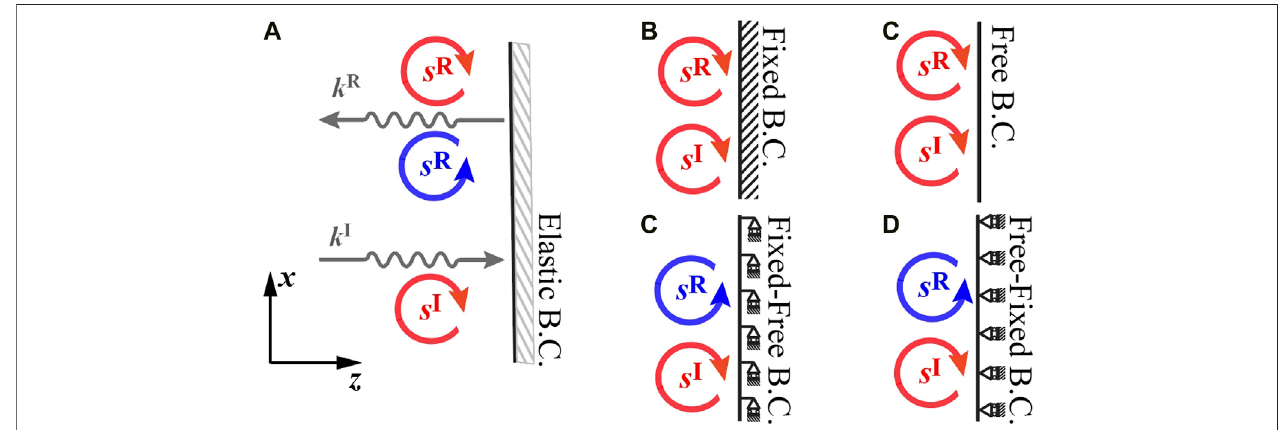
FIGURE3 |(A) Rolling wave re fl ections with normal incidenceat ageneral elastic boundary.In all sub-plots, theincidencewave carries aspin angular momentum, s I y (cid:2) − 1.Here s I and s R indicatethespindensityofincidencewaveandre fl ectionwave,respectively.Theycanbecalculatedusingthe eq.22 .There fl ectionprocessis (B) spin-preserving at the fi xed rigid boundary, (C) spin-preserving at the free boundary, (D) spin- fl ipping at the fi xed-free boundary, and (E) spin- fl ipping at the free- fi xed